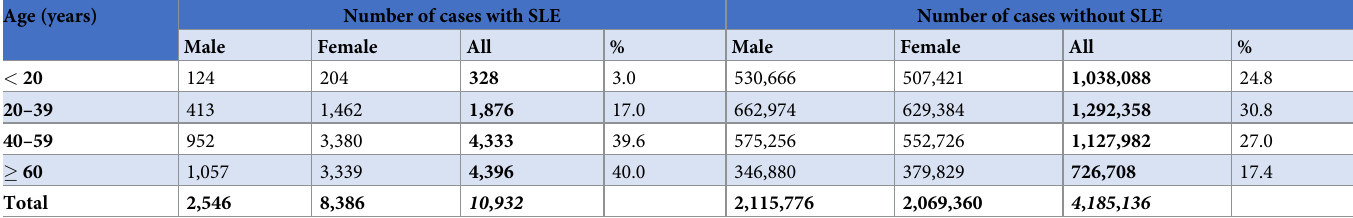
Table 1. Characteristics of the participants.